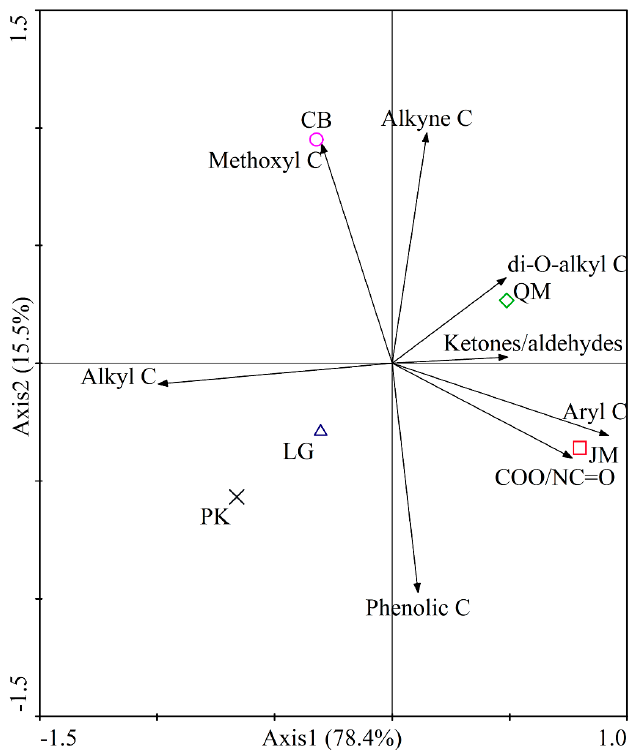
Figure 3. A principal component analyses (PCA) combined ordination plot performed on relative abundance of 7 C functional groups across different revegetation types. JM: Juglans mandshurica ; QM: Quercus mongolica ; CB: Conifer-broadleaf forest; LG: Larix gmelinii ; PK: Pinus koraiensis